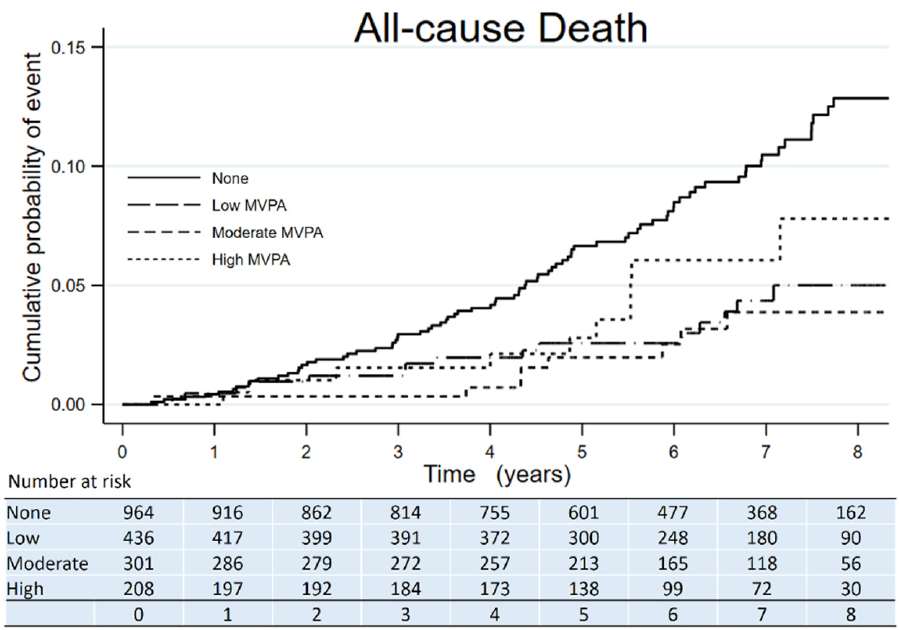
Figure 1. Kaplan–Meier survival curve of all-cause deaths across categories of MVPA amount in adults with nondialysis CKD.